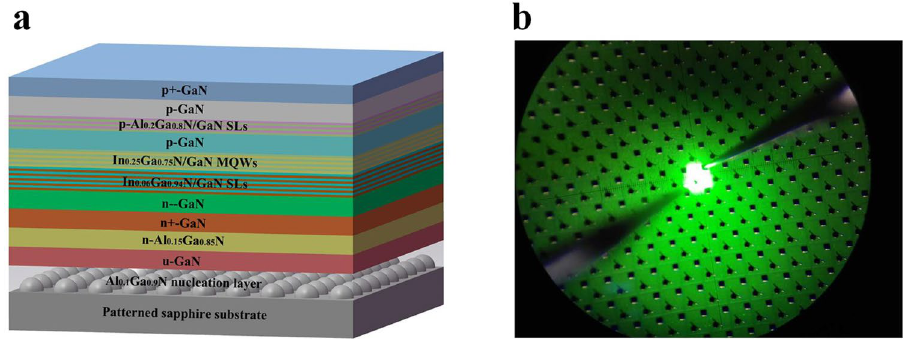
Figure 1. ( a ) Schematic illustration of the green LED structure. ( b ) Electroluminescence image of a green LED at 20